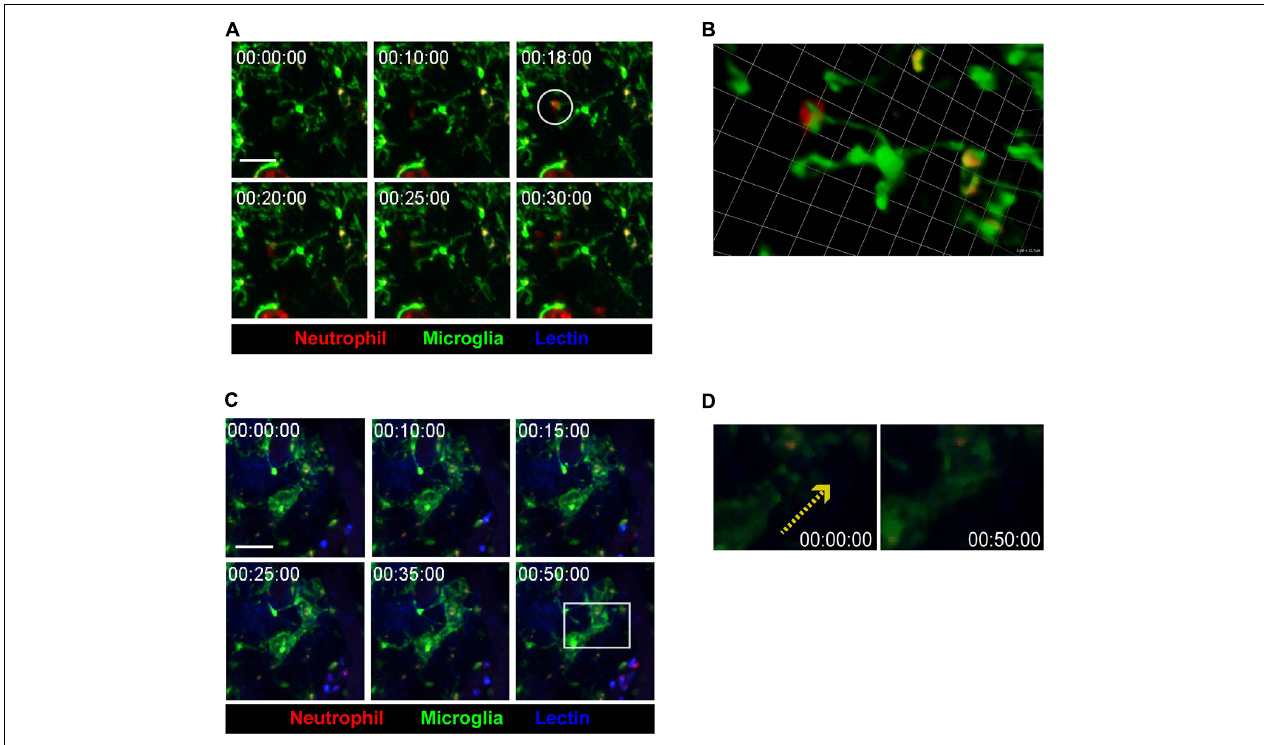
FIGURE 3 | Crosstalk between microglia and neutrophils in inflamed brain parenchyma. CX 3 CR1 GFP / + mice were used to visualize microglia (green) in brain parenchyma using TPIM. CF405M-conjugated lectin was i.v. injected to stain blood vessels (blue). PE-conjugated anti-Ly6G antibody was i.v. injected to label neutrophils (red). (A) A series of representative time-lapse images showing contact between microglia and neutrophils (white circle). Scale bar, 40 µ m (see Supplementary Video 5 ). (B) Magnification of a region of interest, indicated by a white circle in (A) , in 3D. Scale bar per 1 unit. Scale bar, 12.7 µ m. (C) A series of representative time-lapse images showing elongation of microglial processes toward site neutrophil-microglial contact (white square). Scale bar, 40 µ m (see Supplementary Video 6 ). (D) Direction of microglial process elongation from 0 to 50 min (yellow-dotted